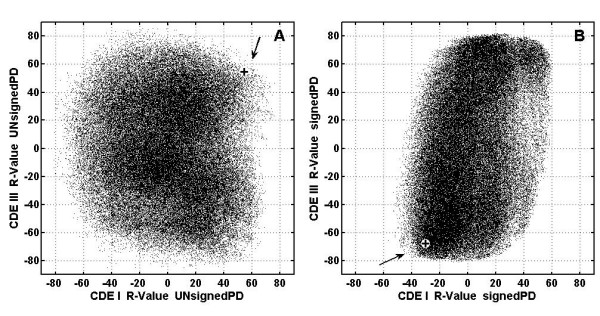
Paired R-value distributions for CDEI & CDEIII from Monte Carlo results. Monte Carlo distributions of paired R values from CDEIII vs CDEI core binding area regressions are presented for 105 randomized PD-scale values for unsignedPD (A) and signedPD (B). The actual values obtained from the true PD-scale are indicated by arrows and marked by '+' signs. The probabilities of better pair values in the respective quadrants are .0001 and .0044 for unsignedPD and signedPD respectively.